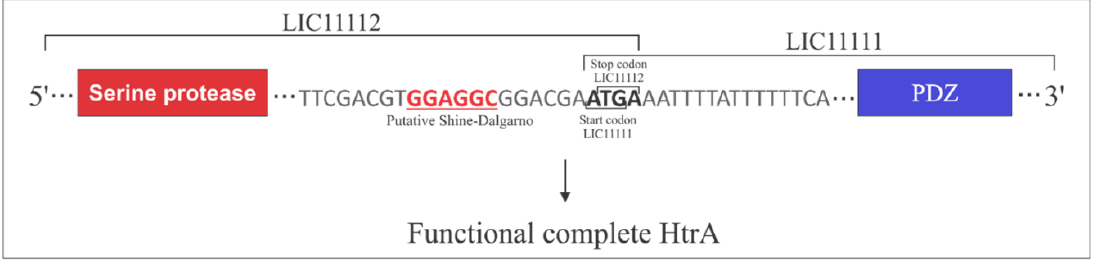
the serine protease and PDZ domains are indicated in the red and blue box, respectively. The